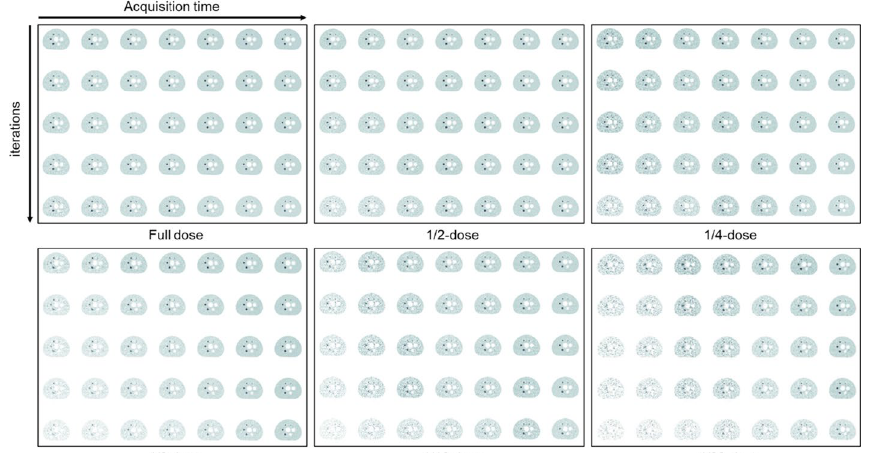
Fig. 1 The schematic figure of transverse image slices of the NEMA IQ phantom achieved at the different acquisition time, iteration number, and injected activity. The PET raw-data were measured from the NEMA IQ phantom with a background activity of ~ 5.2 MBq/L (hot sphere-to-background ratio 30 min. By truncating the list-mode PET raw-data, a series of PET images were reconstructed into 40 s, 1 min, 2 min, 3 min, 5 min, 10 min and 30 min (ordered from left to right column), where the iteration number applied in OSEM-TOF-PSF reconstruction process was 2, 3, 4, 5, and 15 from top to bottom line, respectively. The activity per body weight was estimated from the instantaneous background activity concentration taking into account of the nature decay of 18 F nuclide for a waiting time of 60 min after injection. The activity per body weight ranged from 0.24 to 7.61 MBq/L